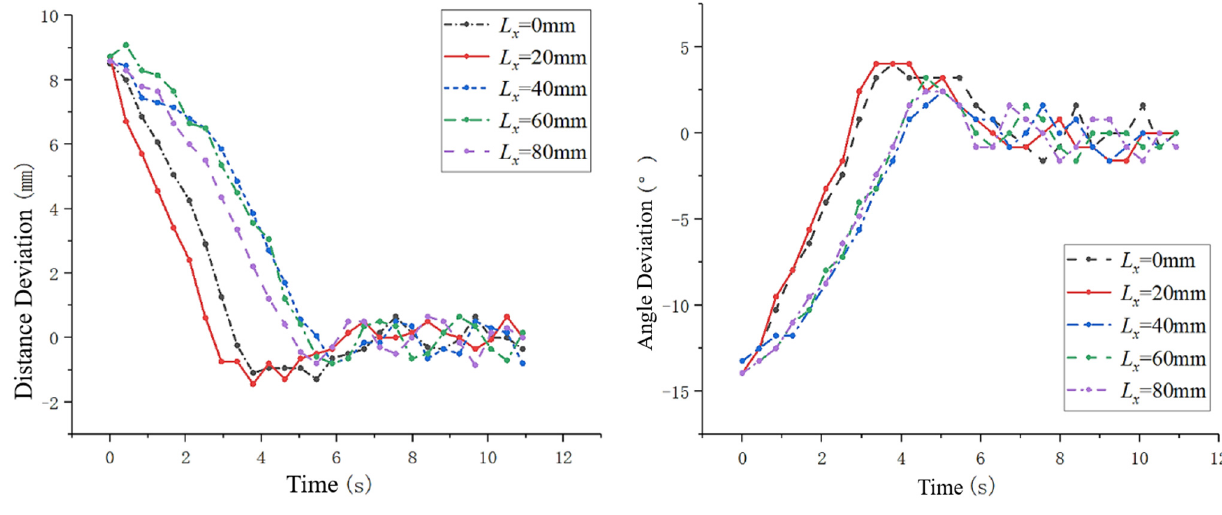
Figure 14. Error of the robot tracking the lane’s centerline.